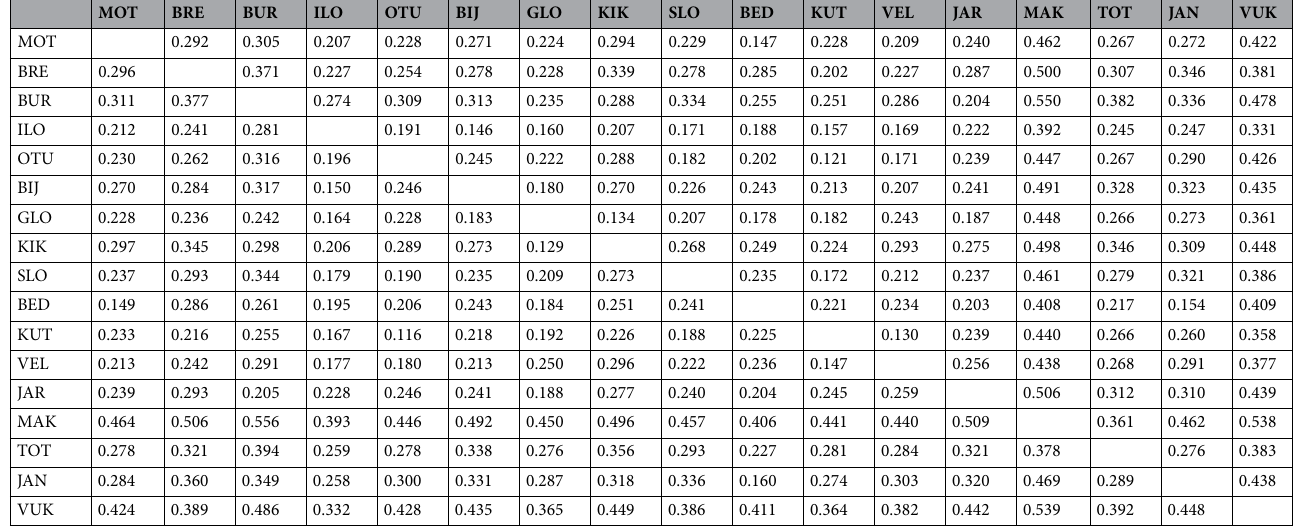
Table 2. Pairwise uncorrected F ST values (below) and F ST values corrected for null alleles (above) from 15 microsatellite loci between all populations pairs (all values are statistically significant, p < 0.05; see Table 1 for populations’